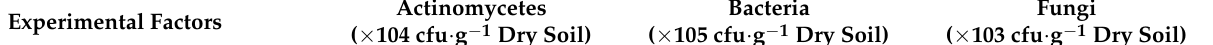
Table 8. Influence of experimental factors on actinomycetes, bacteria and soil